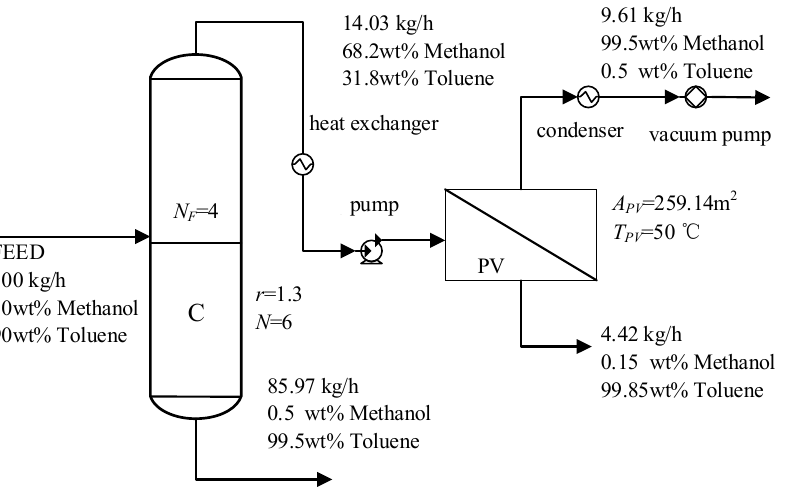
Figure 5. The optimal process structure and parameters of the chitosan membrane, when the feed flow rate is 100 kg/h and the methanol content is 10 wt%.